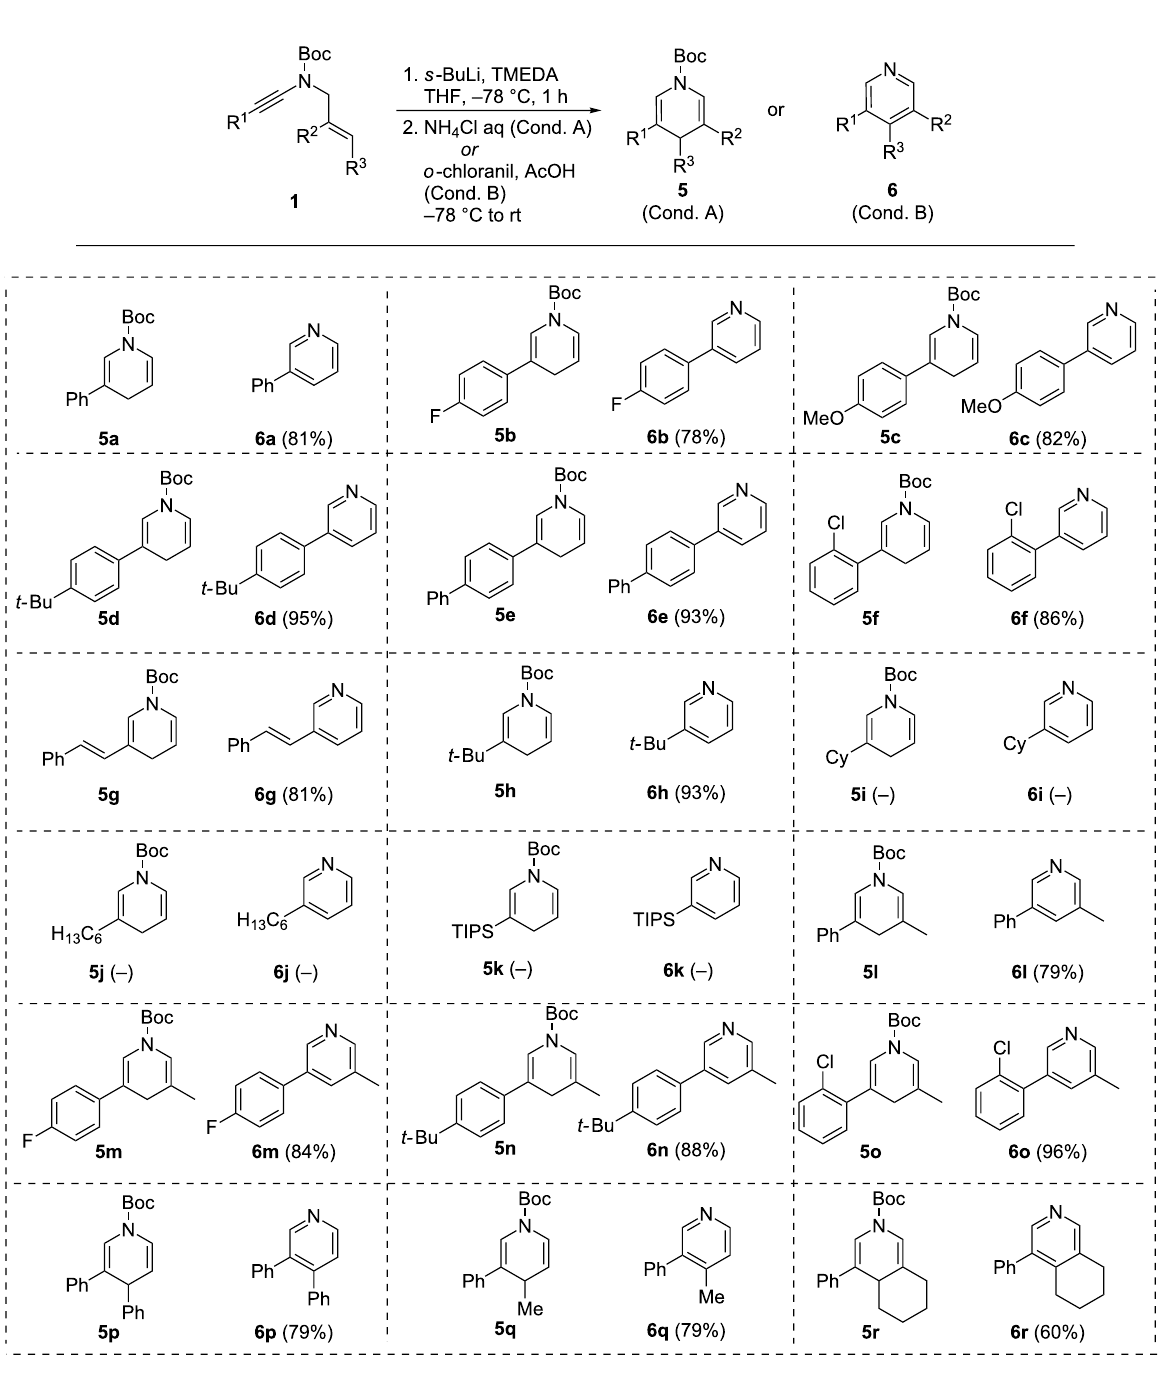
With a chelation-stabilized vinyllithium being formed after the anionic 6-endo-dig cyclization, we next considered the possi- bility of trapping this vinyllithium with an electrophile,